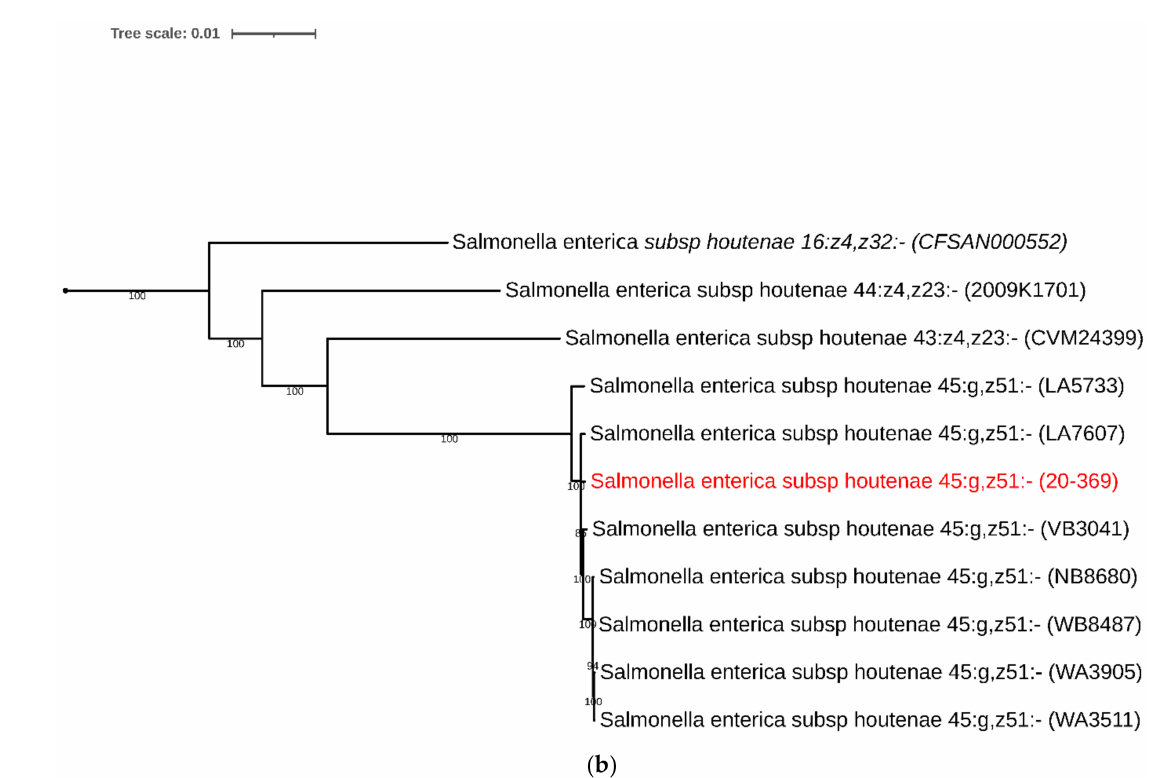
Figure 1. Phylogenetic analysis of 30 complete genomes of Salmonella spp., including strain 20-369, using SNP analysis. ( a ) The phylogeny was rooted at midpoint. ( b ) The phylogeny of Salmonella enterica subsp. houtenae strains. The scale bars show the number of substitutions per site. The numerical values represent 1000 bootstrap replicate values above